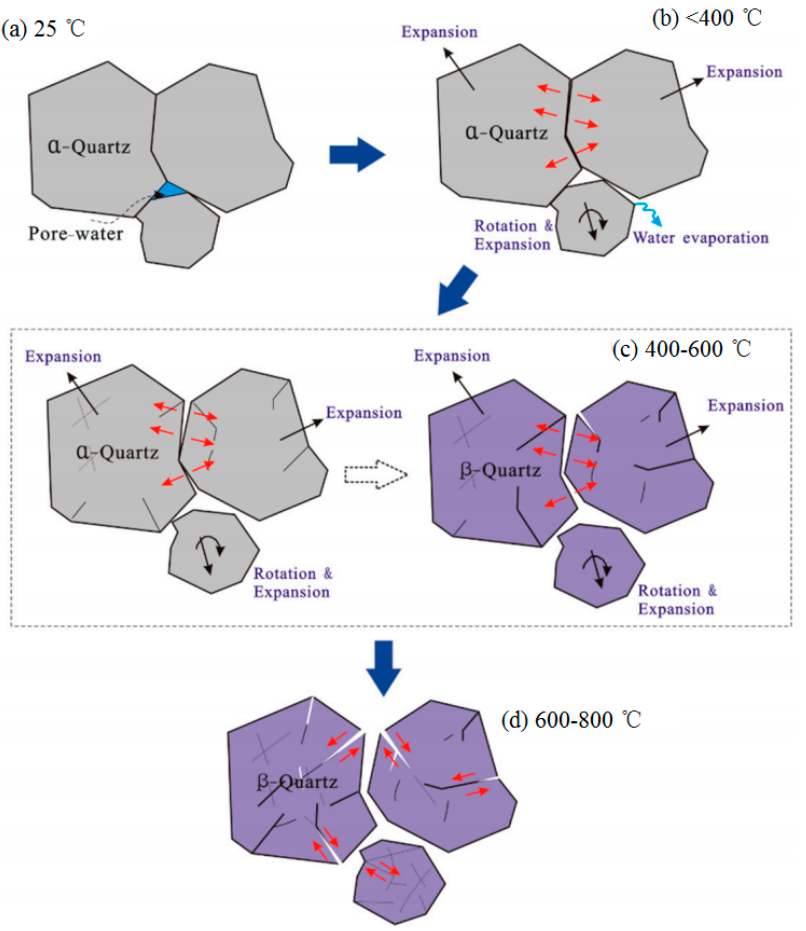
Figure 18. Diagrams of the microstructure development process of quartz crystals [7]. ( a ) 25 °C; ( b ) <400 °C; ( c ) 400–600 °C; ( d ) 600–800 °C.